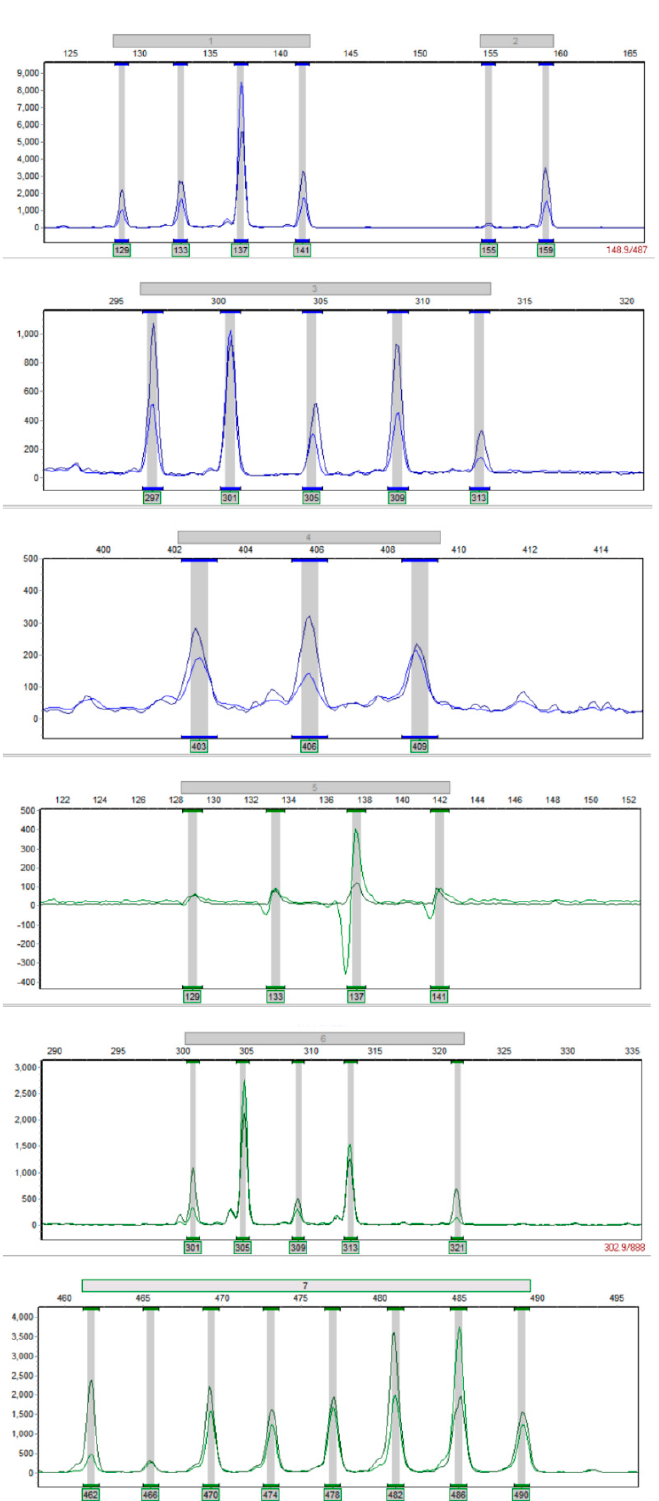
Figure 1. The capillary electrophoresis diagram of the seven primer pairs in group G1. (The 1 to 7 in this Figure correspond to alleles loci Cun463, Cun378, Cun500, Cun626, Cun672, Cun586 and Cun148, respectively).